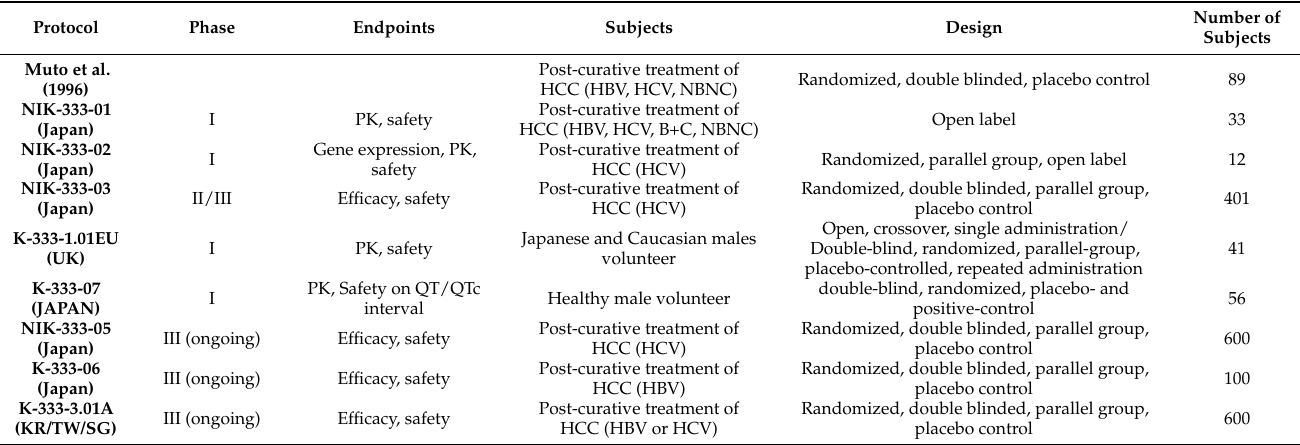
Table 1. Peretinoin clinical